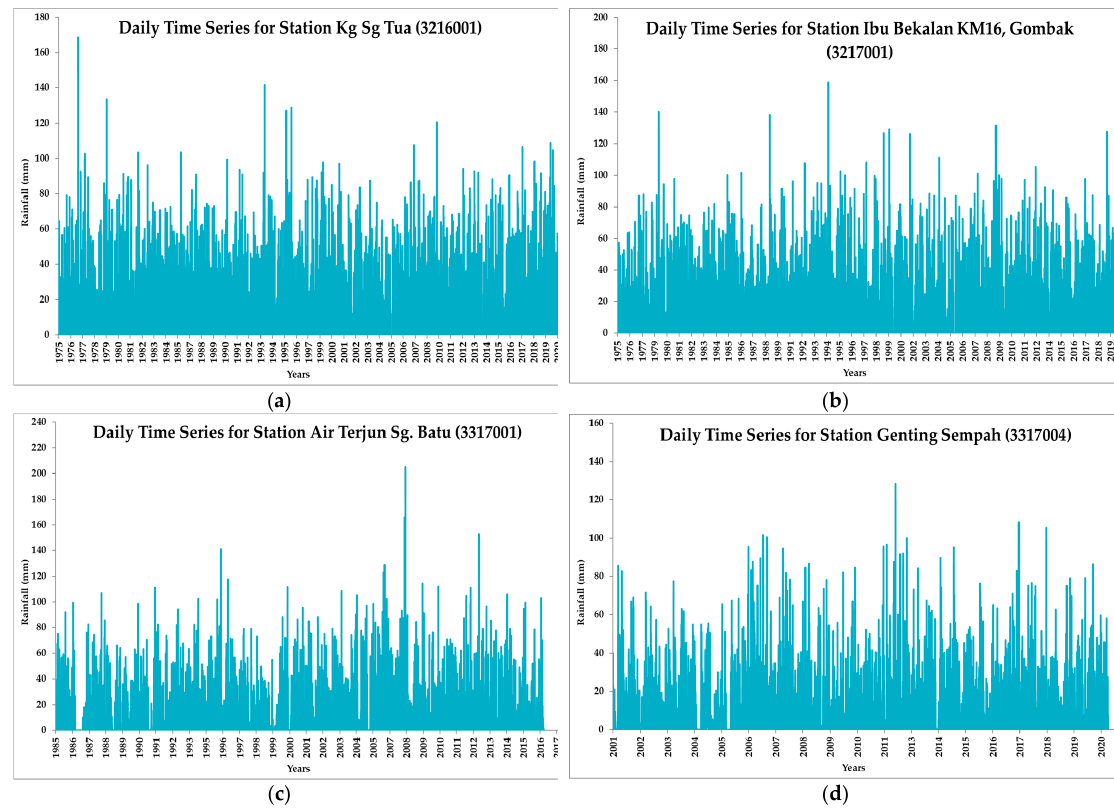
Figure 8. Daily rainfall time series of the station ( a ) Kg Sg Tua (3216001), ( b ) Ibu Bekalan KM16 (3217001), ( c ) Air Terjun Sg Batu (3317001), and ( d ) Genting Sempah (3317004).